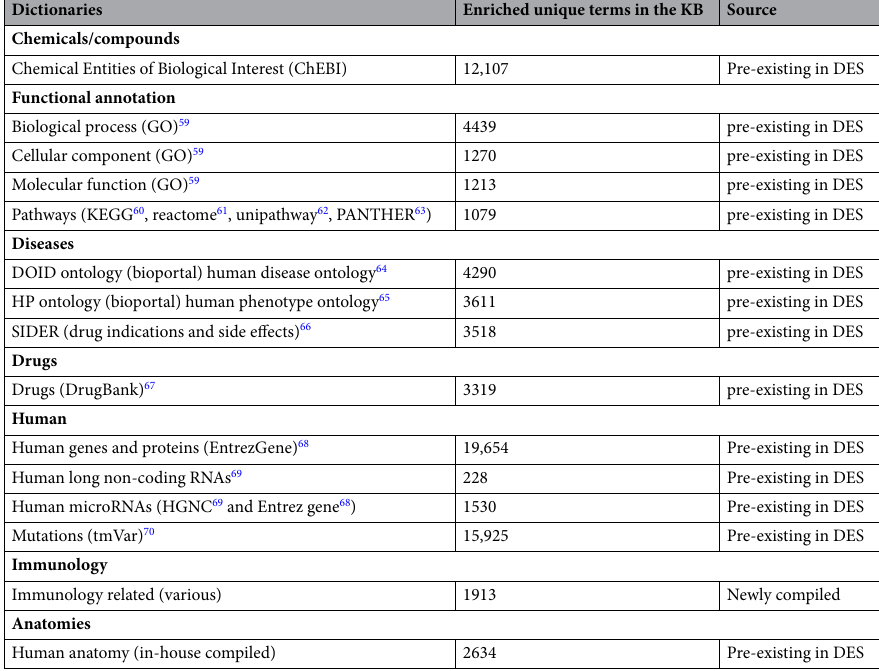
Table 1. List of dictionaries used in DES-Tcell with source references.